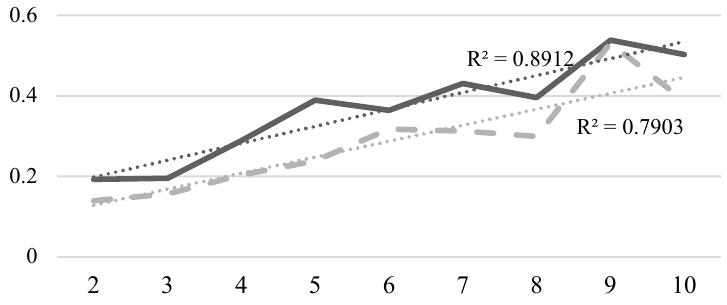
Figure 4. Mean accuracy by number of semesters of TL instruction completed by CR test respondents, Dark line: function words, Light line: content words. Fitted regression lines (dotted) are shown with corresponding R 2 values.